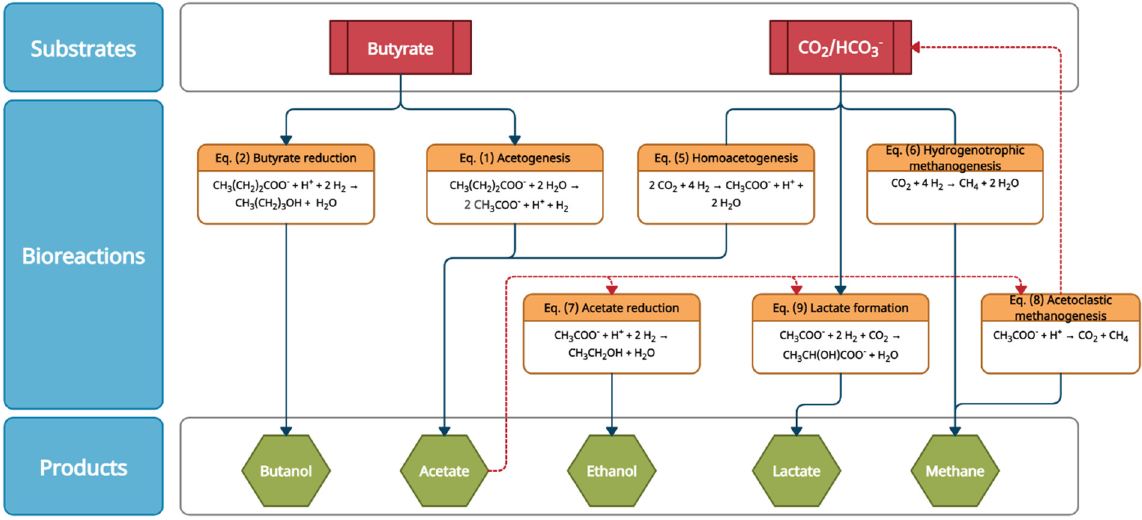
Figure 8. Catabolic reactions used for the analysis of the thermodynamic system state.